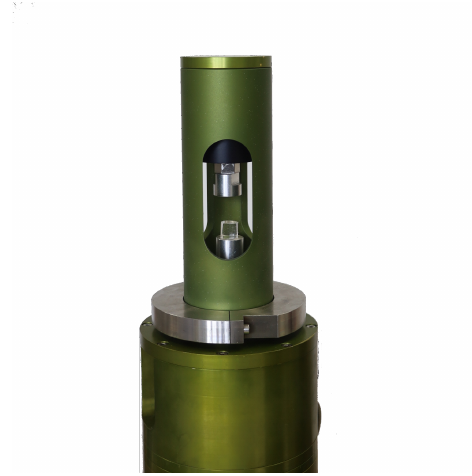
Figure 1. Experimental setup used for quasi-static